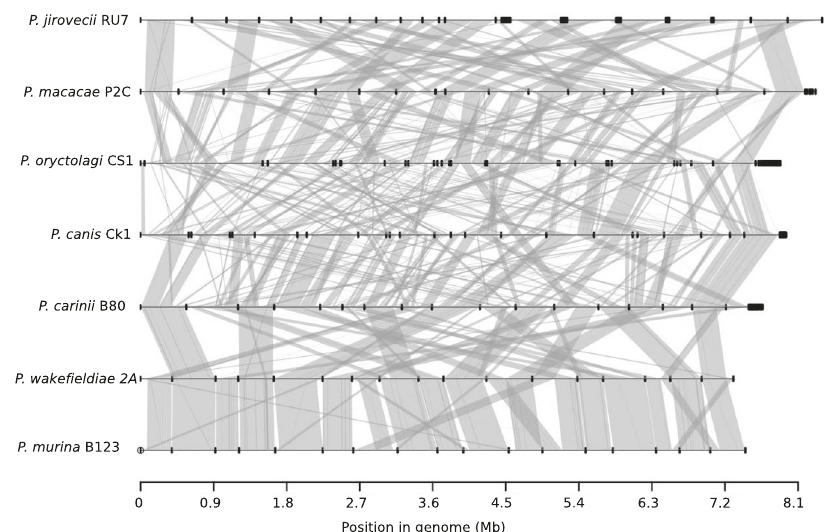
Fig. 1 Whole-genome structure and synteny among Pneumocystis species. Species names and their genome assembly identi fi ers are shown on the left. Horizontal black lines on the right represent sequences of all scaffolds for each genome laid end-to-end, with their nucleotide positions indicated at the bottom. Dark thick squares represent short scaffolds. Syntenic regions between genomes are linked with vertical gray